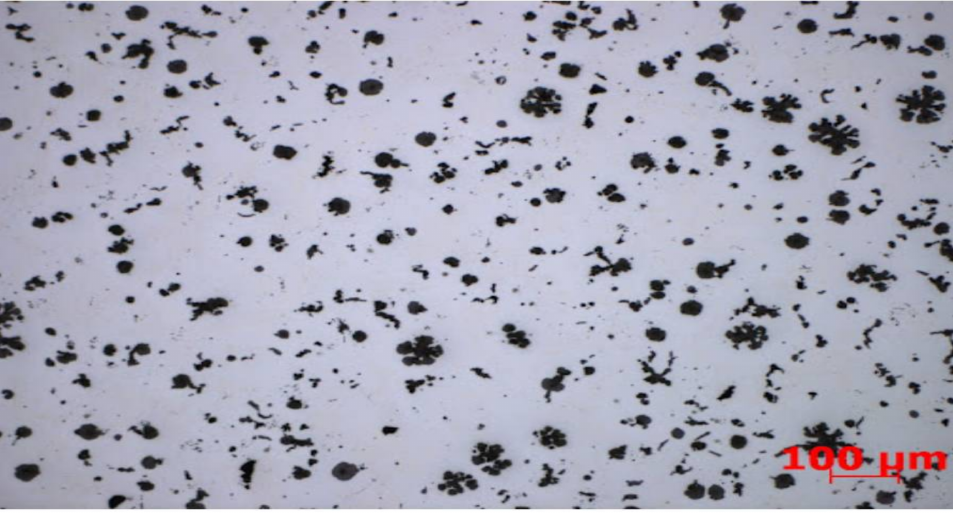
Figure 1. Sample photo of the microstructure. It shows an instance from the Rm set, where the photos are grouped by tensile strength. In this case, it is a low-resistance microstructure. Source: